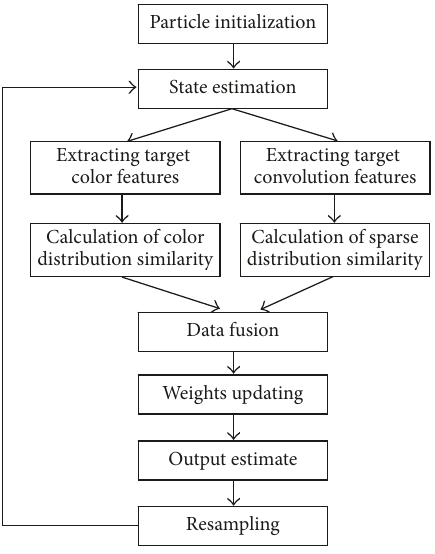
Figure 1: Flow chart of the